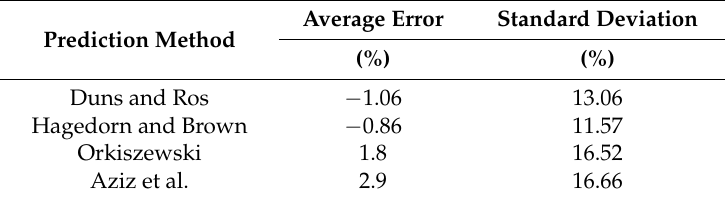
Table 3. Statistical results for the various prediction